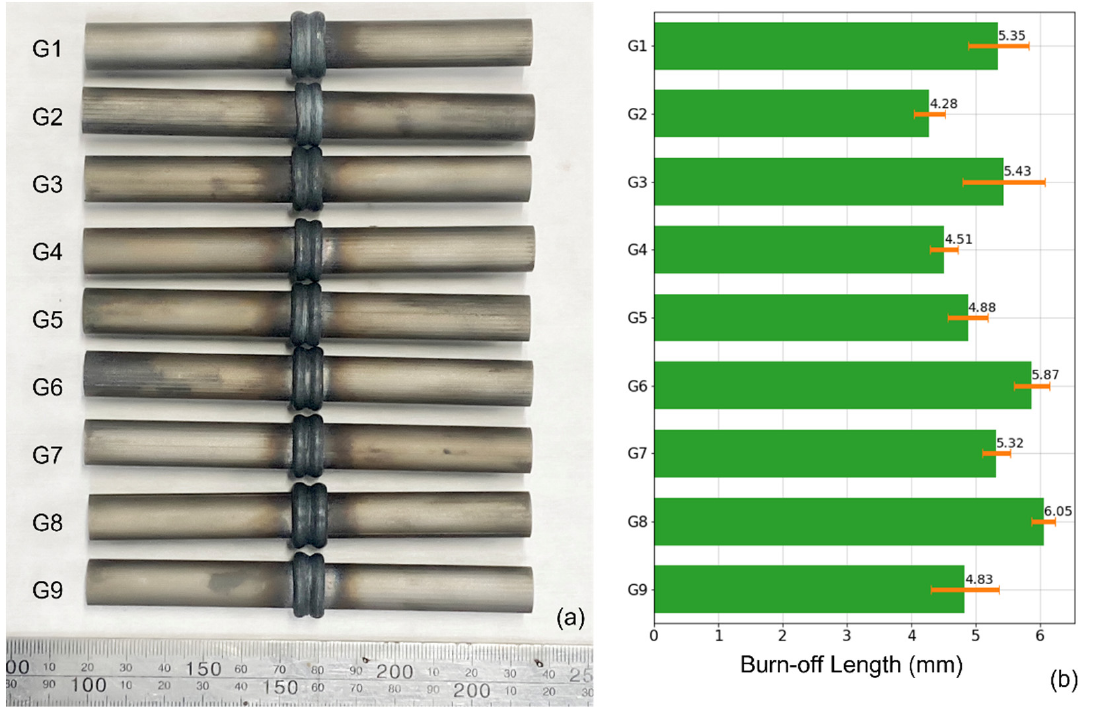
Figure 3. Weldments corresponding to nine groups of experiments with different process parameters ( a ), and their BOL values ( b ), from top to bottom, for Groups 1–9, respectively.